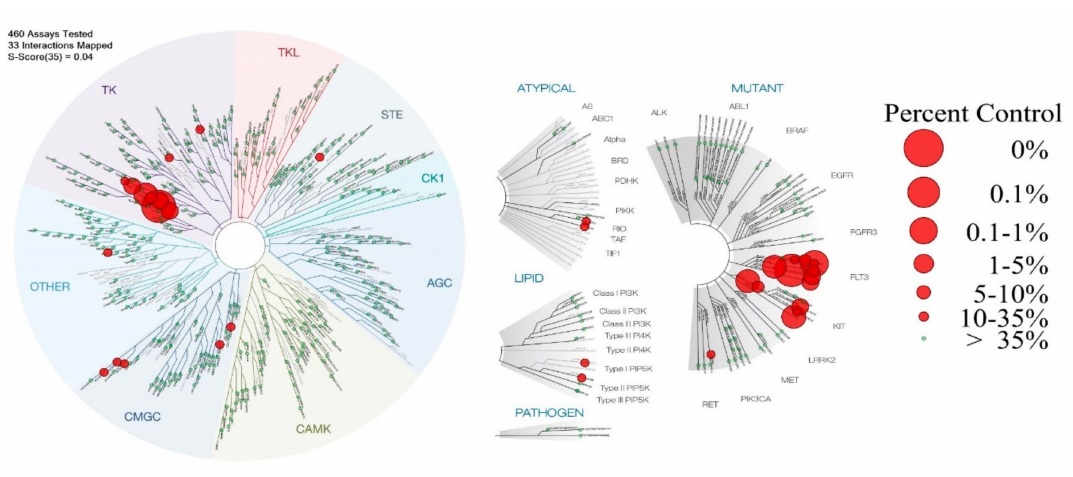
Figure 3. Selectivity profile of compound 1 against 468 protein kinases. Relative binding a ffi nities are indicated by red circles in a phylogenetic kinome tree for wild-type enzymes ( left ) and atypical / mutant / lipo / pathogen variants ( right ). The sizes of the red circles are proportional to the strength of the binding; the larger circles indicate higher a ffi nity. A total of 33 of the best interactions with binding levels 35% greater than the control (red circles) at a fixed 10 ì M concentration of test compound were mapped. Selectivity factor (S), S35 = 0.04. Image generated using TREEspot ™ Software Tool and reprinted with permission from KINOMEscan ® , a division of DiscoveRx Corporation, © DiscoveRx Corporation 2010. Table 2. Primary screening results 1 of KINOMEScan assay for compound 1 , at 10 µ M, for the most inhibited